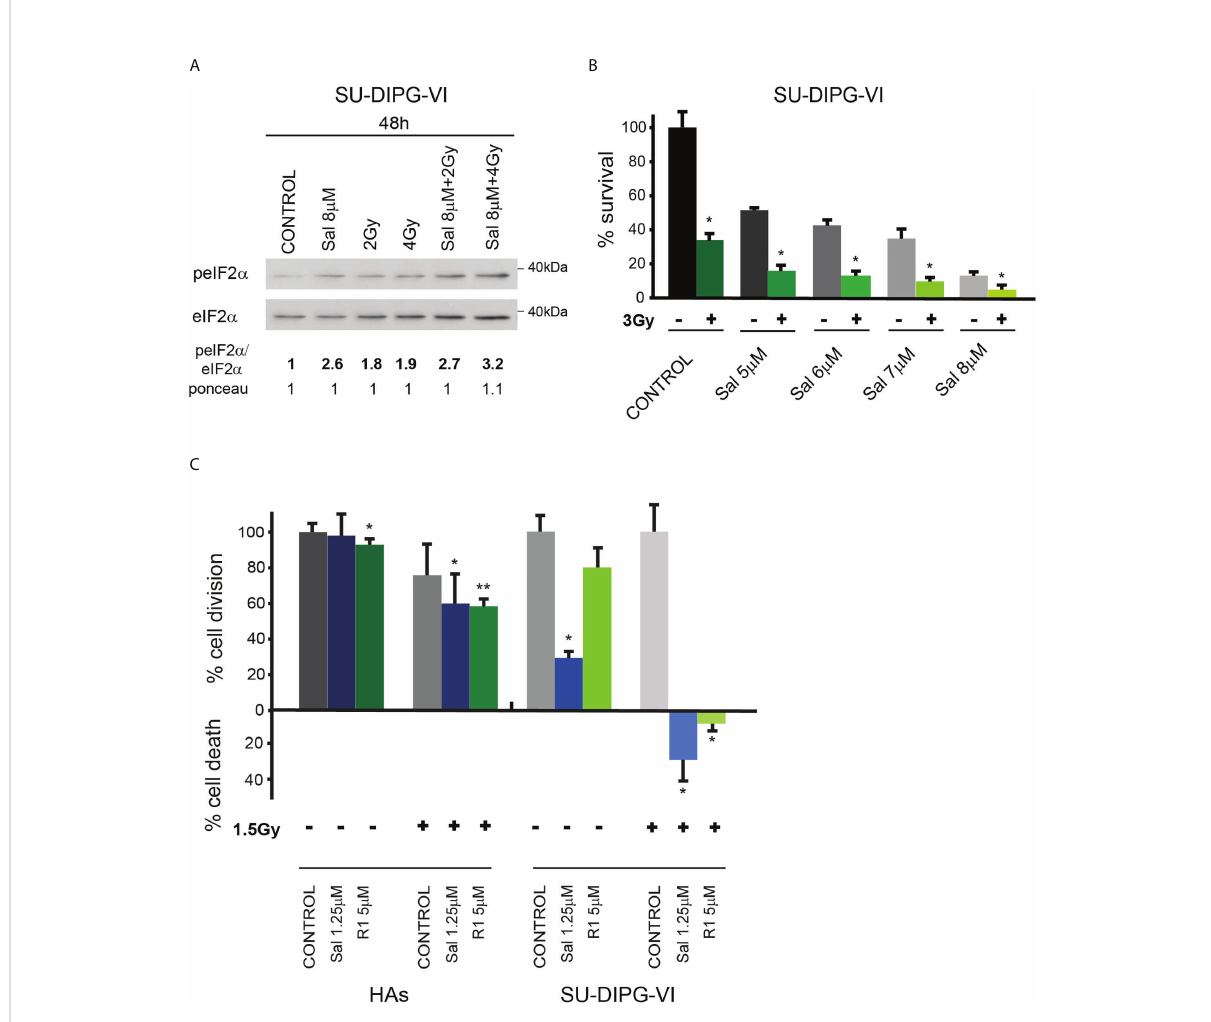
FIGURE 6 Combination of radiation with salubrinal or raphin-1 enhanced decrease in cell survival: (A) . SU-DIPG-VI cells were irradiated and treated with drugs 24 h post-plating and incubated for additional 48 h before processing for Western blot analysis of treatment-induced changes in the ratio of peIF2 a /eIF2 a . Numbers at the bottom of the autoradiograms indicate changes of peIF2 a /eIF2 a and differences in loaded proteins (Ponceau) relative to control. (B) . SU-DIPG-VI cells were plated in triplicates at a density of 11,500 cells/cm 2 and 24 h later were irradiated and treated with salubrinal. Cells were counted 7 days following treatment initiation. Values are mean survival (%) ± S.D relative to control. Differences among all experimental groups, as well as between each experimental group and control, were signi fi cant — *p< 0.05. (C) . SU-DIPG VI and HA cells were plated in triplicates at a density of 3,300 cells/cm 2 and treated with drugs and radiation 24 h post-plating. Values are mean number of cell division or cell death (%) ± S.D relative to control. Differences among all experimental groups as well as between each experimental group and control were signi fi cant for SU-DIPG-VI. When indicated, signi fi cance was observed between treated and control untreated HAs, but not among all experimental groups — *p< 0.05, **p< 0.005. Gy — gray, Sal — salubrinal, R1 — Raphin-1. The experiments were reproduced once with similar